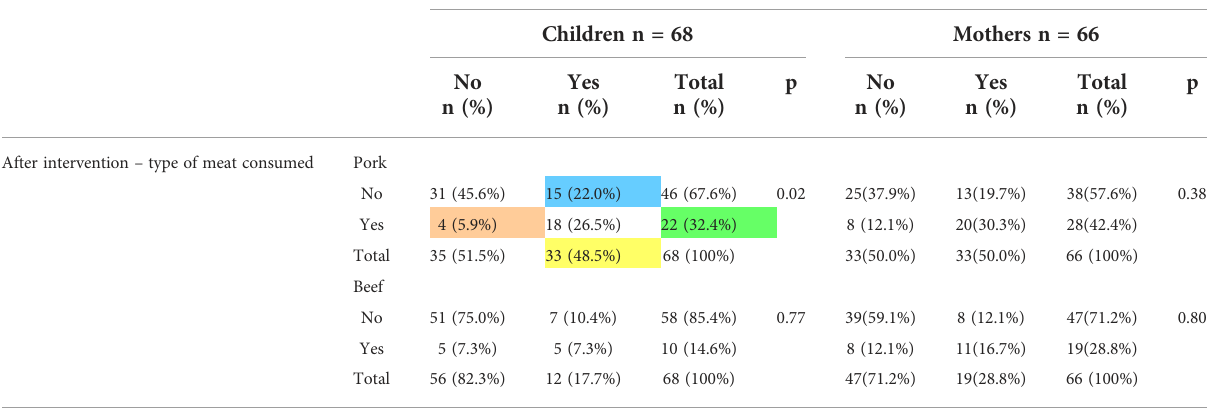
TABLE 7 Effect of one-year dietary education on the types of meat consumed by studied children and their mothers. Assessed habit